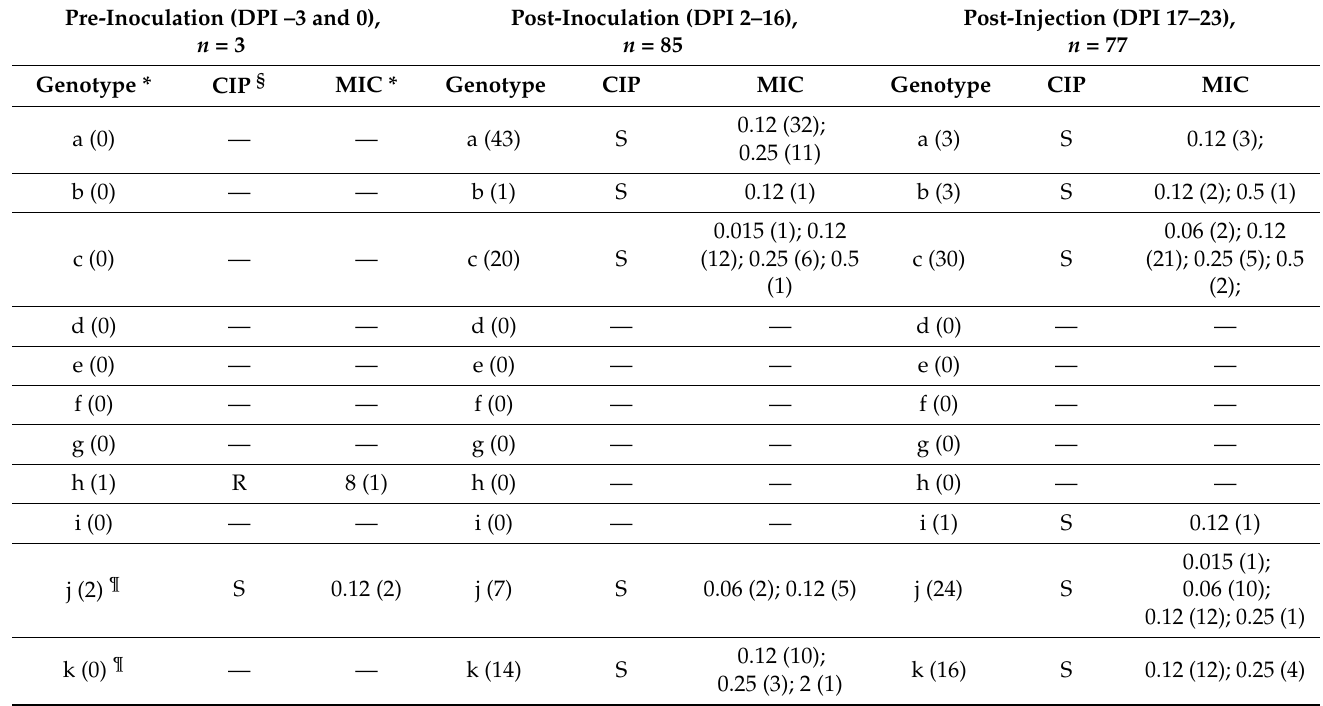
Table 2. PFGE profiles and ciprofloxacin MICs of C. jejuni isolates obtained from calves in groups administered with enrofloxacin (Groups 2, 3, 4, and 5) # .